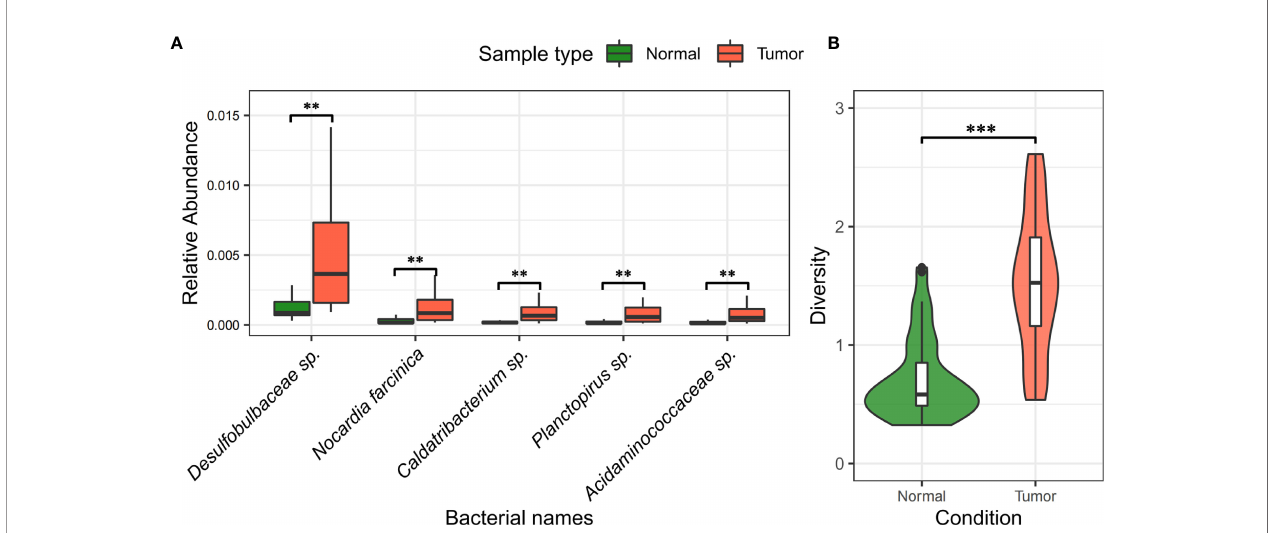
FIGURE 5 | Difference and diversity of bacteria in liver cancer samples. (A) Differentiation of bacteria between liver tumor tissue and normal tissue. “ ** ” indicates FDR < 0.05; “ *** ” indicates FDR < 0.001. (B) Analysis of alpha diversity of bacteria in tumor and normal tissues. The green color on the left indicates normal samples, the red part on the right indicates tumor samples, and the middle BASE part indicates the interquartile